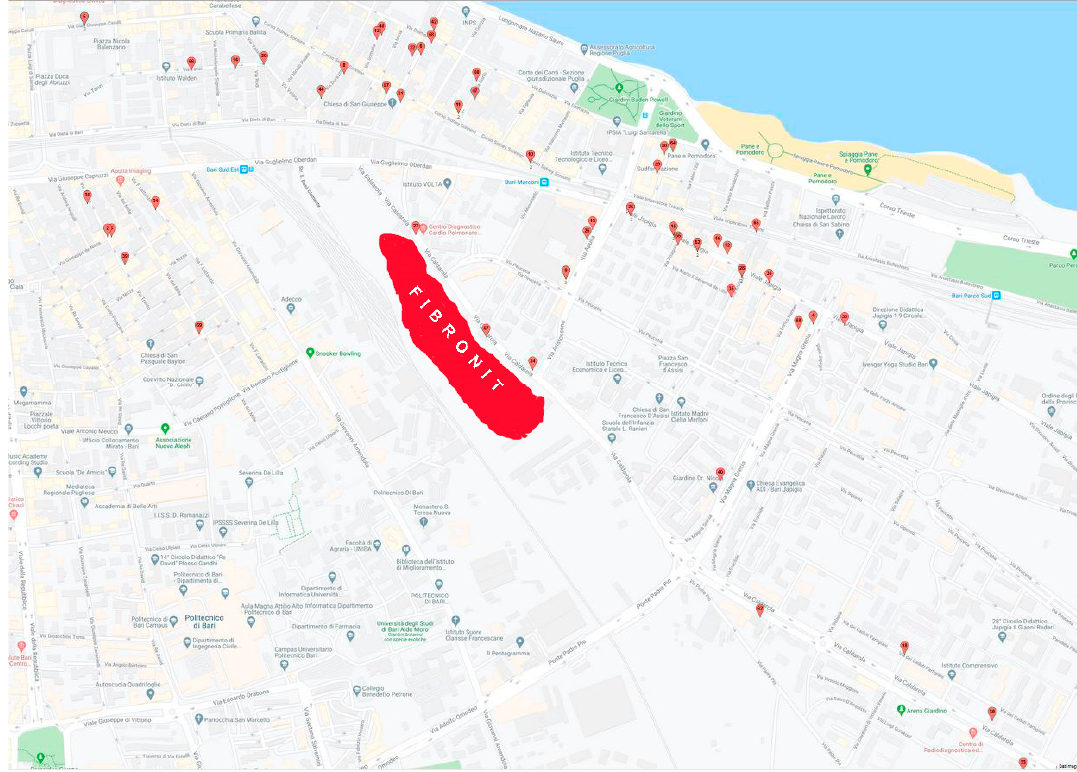
Figure 1. Graphic representation of the Fibronit area and all the addresses of the 71 MM cases.